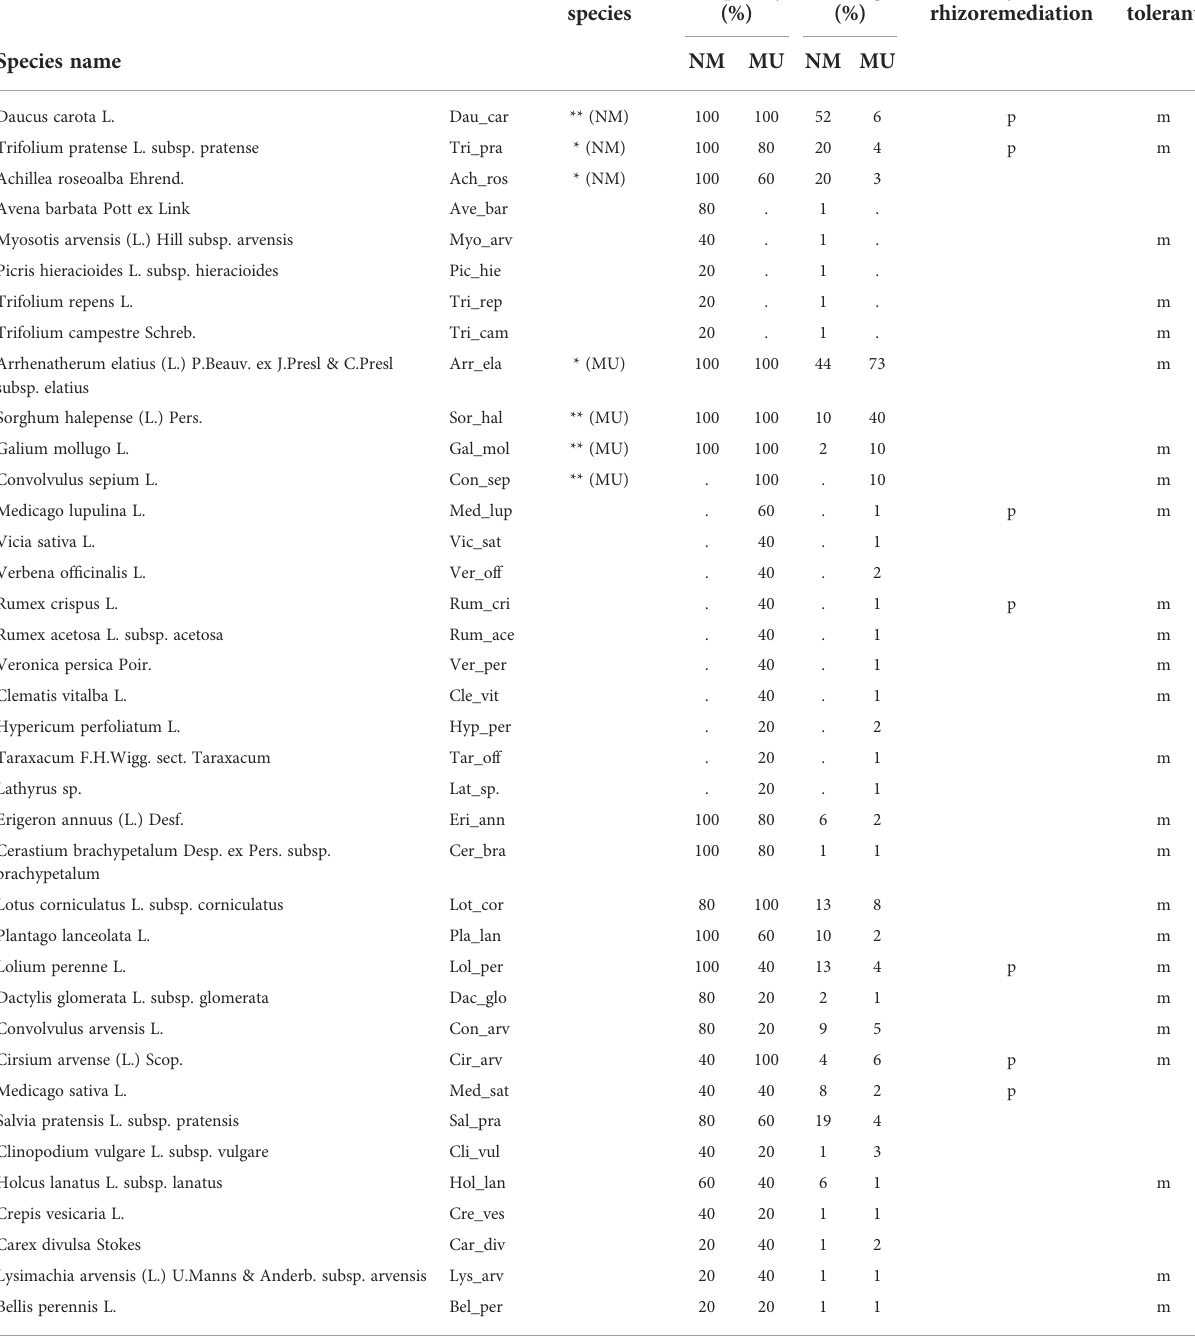
Indicator Frequency Coverage Phyto- Metal species (%) (%) rhizoremediation